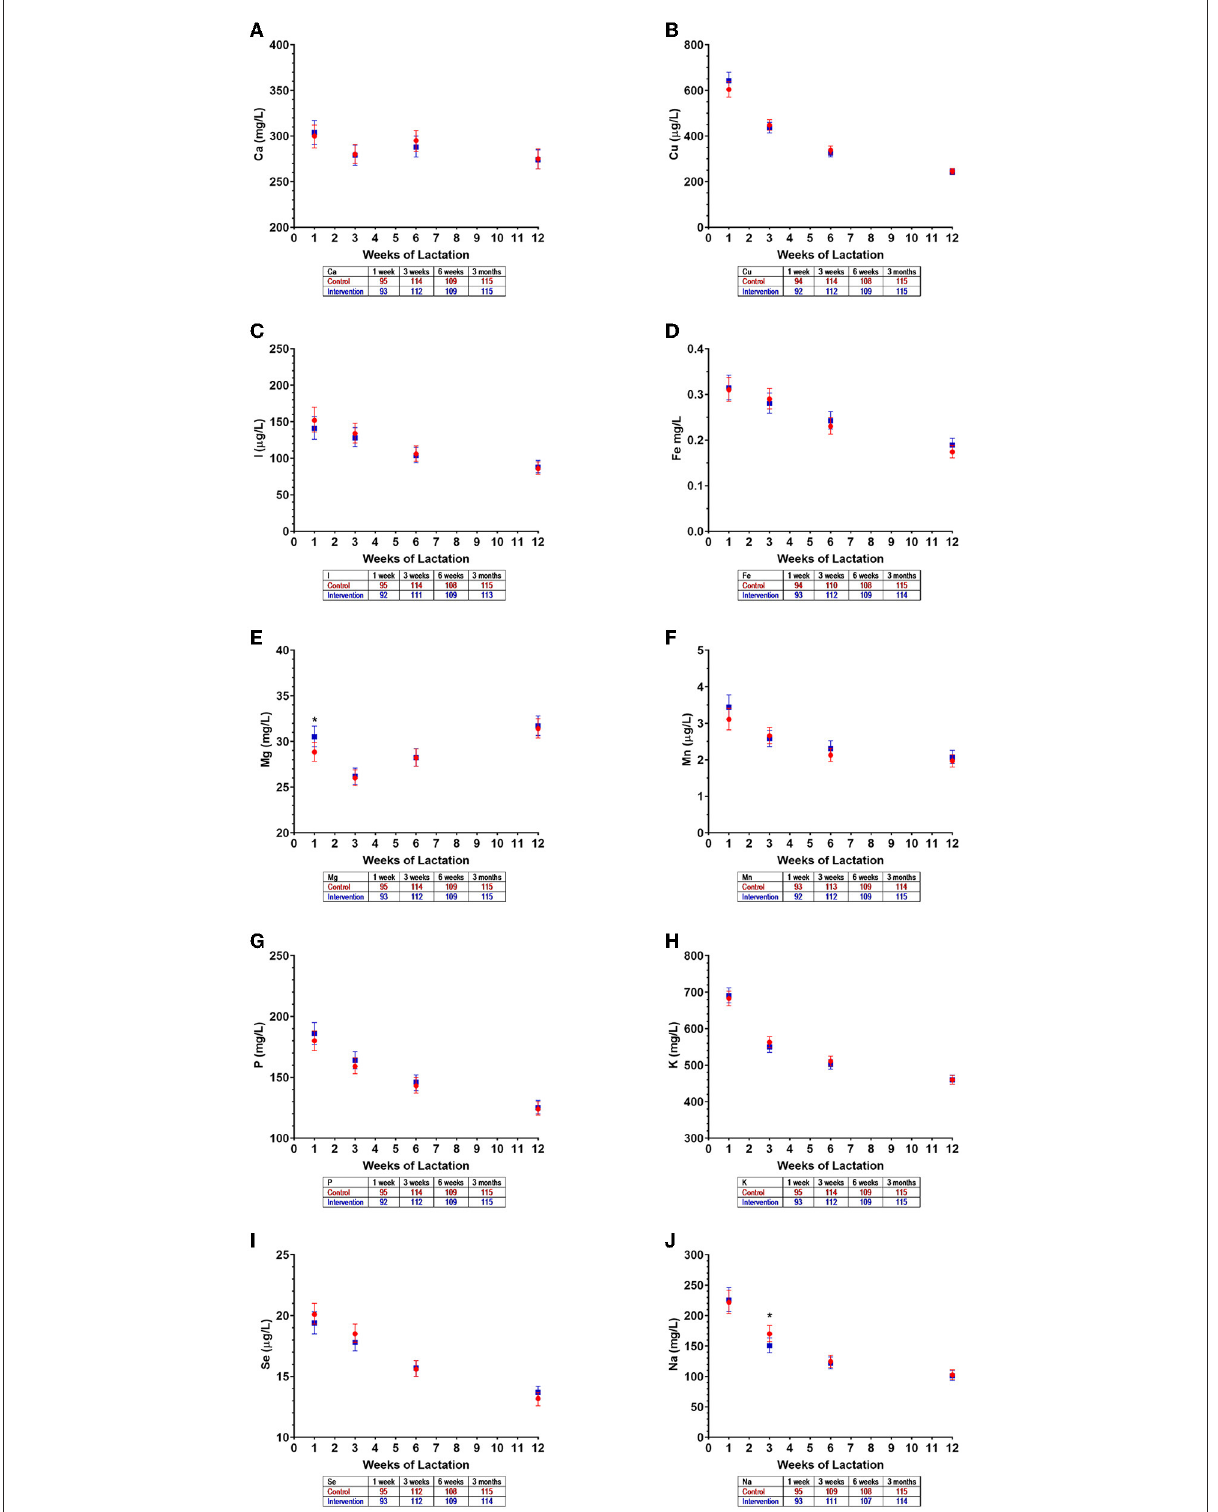
FIGURE3 Mineral concentrations in human milk of control ( ) and intervention ( ) groups in the NiPPeR study during the first 3 months of lactation: (A) calcium, (B) copper, (C) iodine, (D) iron, (E) magnesium, (F) manganese, (G) phosphorus, (H) potassium, (I) selenium, and (J) sodium. Data are the least-squares means (i.e., adjusted means) for each group, adjusted for visit, an interaction term (group*visit), study site, adherence, maternal pre-pregnancy body mass index, and gestational age at birth; error bars represent the respective 95% confidence intervals. * p < 0.05 for a difference between intervention and control groups at a given time point. The number of HM samples per group analyzed at a given time point are provided in the tables below the x